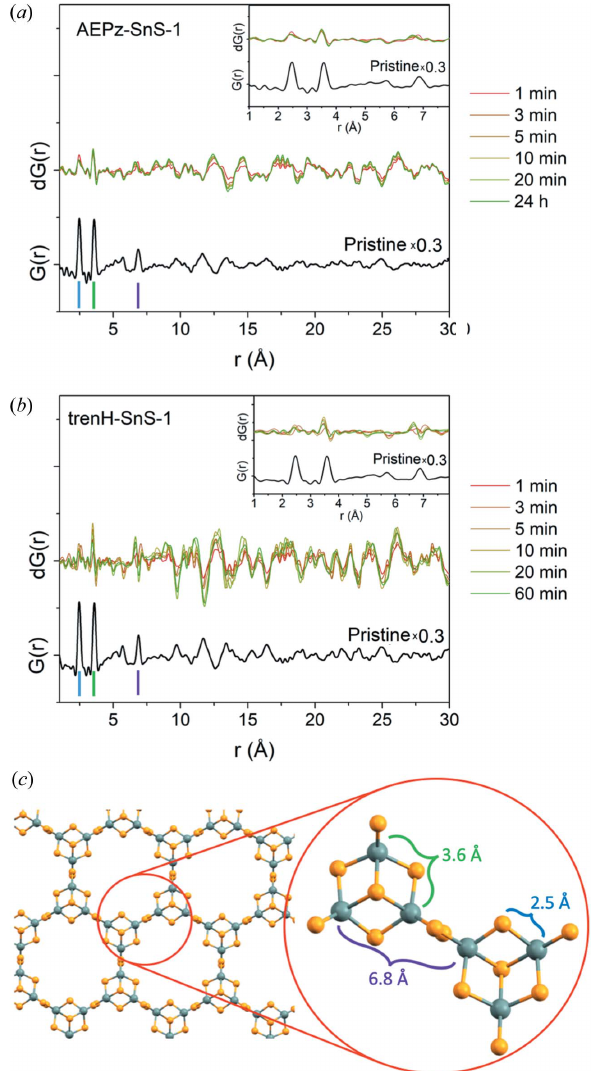
Figure 3 Differential PDFs [d G ( r ) = PDF t (cid:2) PDF t =0 ] of ( a ) AEPz-SnS-1 and ( b ) trenH-SnS-1 at different times t of dispersion in water. The PDFs of the pristine compounds (scaled (cid:7) 0.3) are shown (black) below the dPDFs for comparison. Insets: dPDFs of short-range correlations. ( c ) Thiostannate layer, highlighting two clusters and interatomic distances of pronounced correlations in the